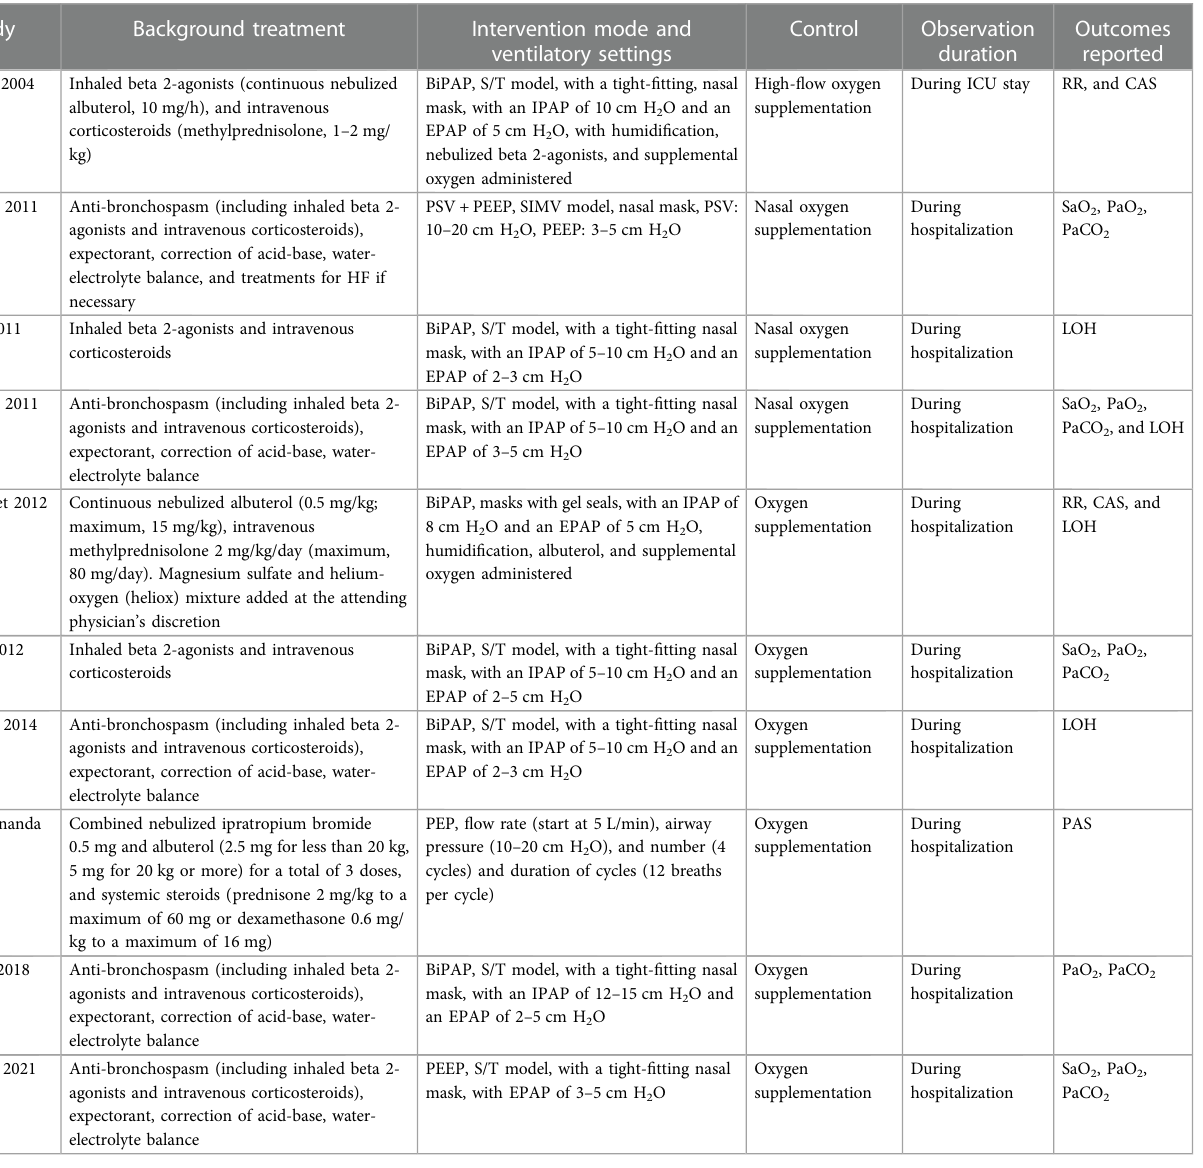
TABLE 2 Characteristics of the intervention and outcomes reported.